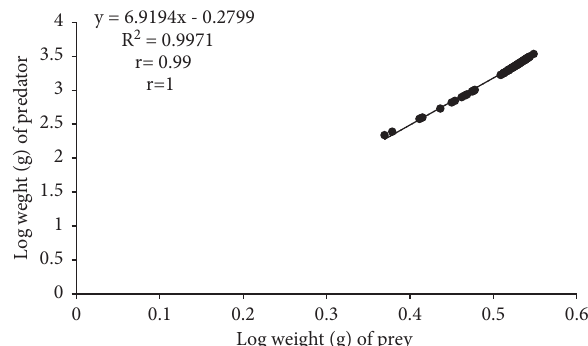
Figure 9: Relationship between prey body weight and total weight of Heterotis niloticus